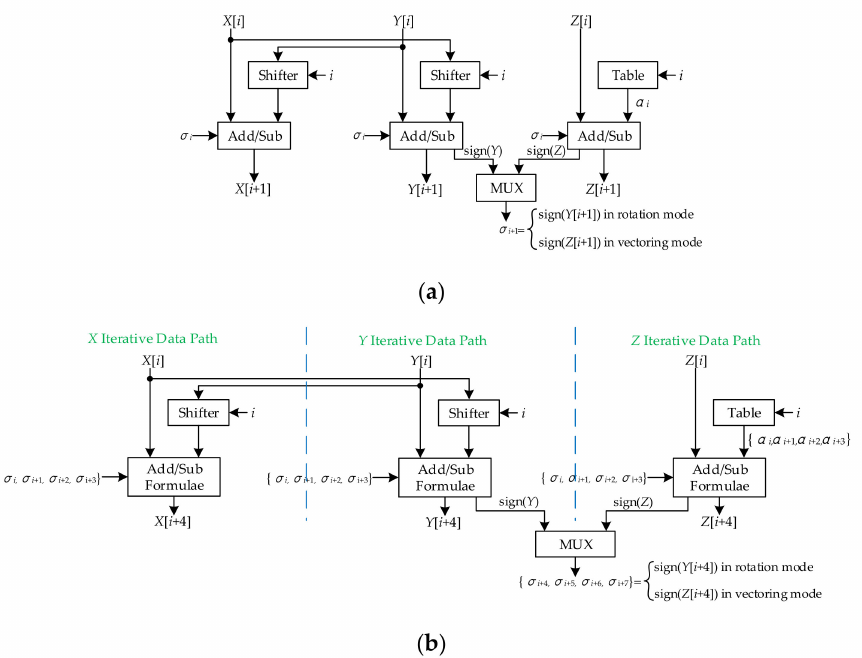
Figure 1. ( a ) Hardware architecture of basic CORDIC; ( b ) hardware architecture of